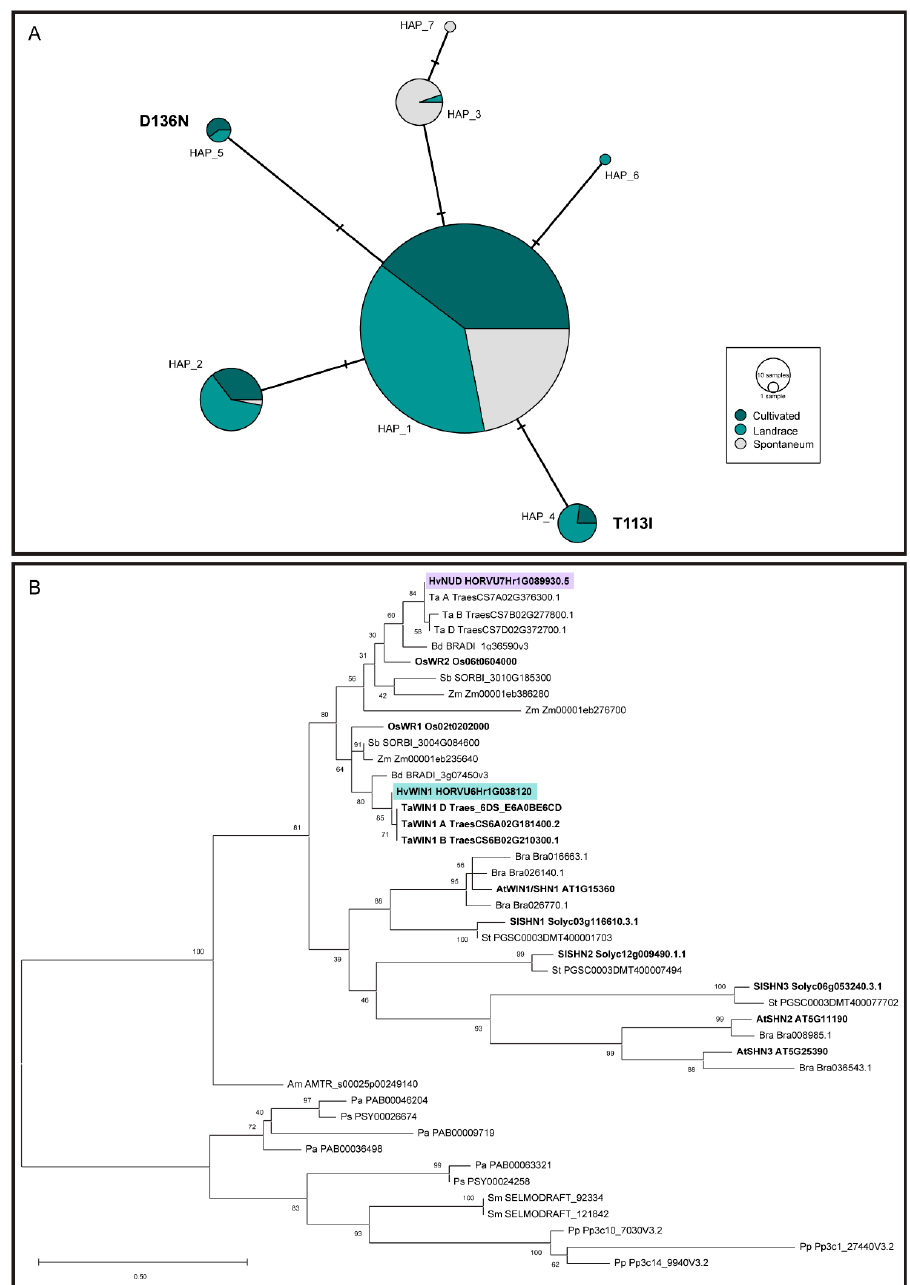
Figure 3. Sequence analyses of HvWIN1 and SHN transcription factors. ( A ) Median-joining network for HvWIN1 haplotypes. SNPs were identified comparing HvWIN1 exonic regions of 456 barley lines. Node size is relative to haplotype frequency. Bars between two nodes indicate the number of nucleotides within the sequence that differ between haplotypes. Amino acid changes are indicated in bold. ( B ) Phylogenetic relationship of SHN transcription factors across representative land plant species. Evolutionary analysis was inferred by using the Maximum Likelihood method and JTT matrix-based model in MEGA 11 [61,62] The tree with the highest log likelihood ( − 3217.61) is shown. The percentage of trees in which the associated taxa clustered together in 300 bootstrap replications is shown next to the branches. Hv, Hordeum vulgare ; Ta, Triticum aestivum ; Bd, Brachypodium distachyon ; Os, Oryza sativa ; Sb, Sorghum bicolor ; Zm, Zea mays ; Bra, Brassica rapa ; At, Arabidopsis thaliana ; Sl, Solanum lycopersicum ; St, Solanum tuberosum ; Am, Amborella trichopoda ; Pa, Picea abies ; Ps, Pinus sylvestris ; Sm, Selaginella moellendorffii ; Pp, Physcomitrium patens . HvNUD is highlighted in purple, HvWIN1 is highlighted in green. Gene models in bold indicate functionally characterised genes.